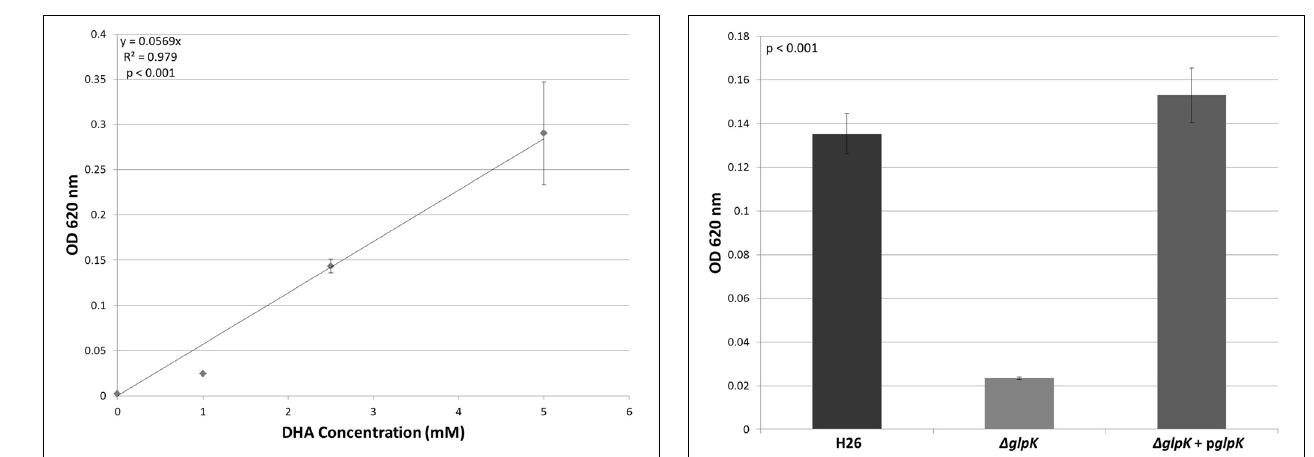
FIGURE 4 | Cell density of H26, (cid:2) glpK , and (cid:2) glpK + p glpK at stationary phase when grown on 5mM DHA. Cell density is represented by the average optical density (OD 620 ) reading of three cell culture replicates. Error bars depict the standard deviation of the averages. ANOVA single factor, p < 0 .